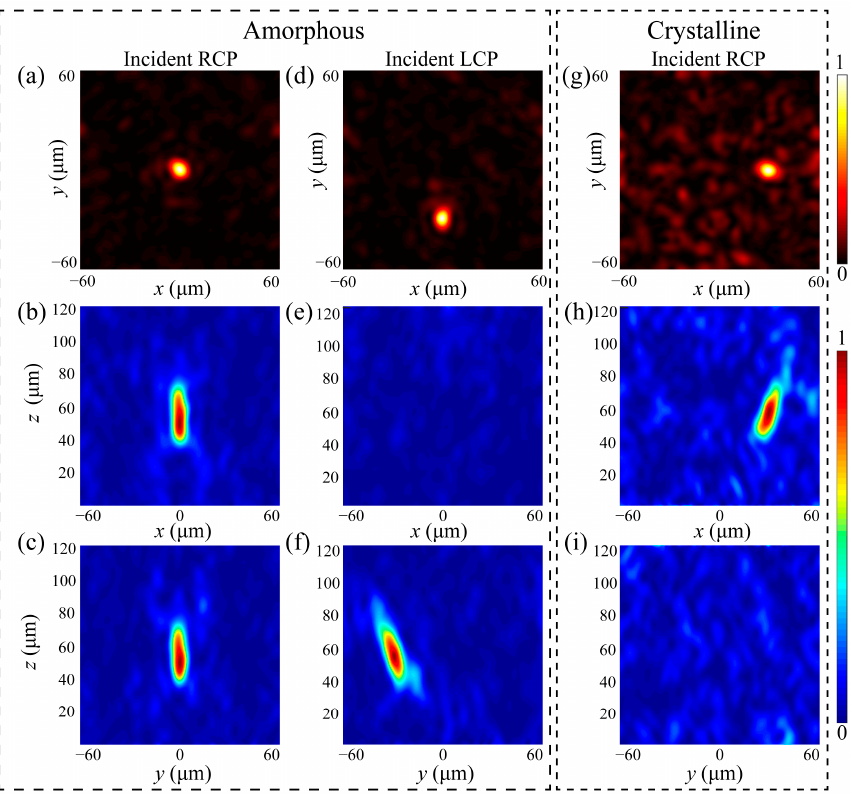
Figure 3. Simulated performance of the designed multi-focus metalens at different observation planes. ( a – c ) Electric field distributions when GSST is in A-state under RCP incidence. ( d – f ) Electric field distributions when GSST is in A-state under LCP incidence. ( g – i ) Electric field distributions when GSST is in C-state under RCP incidence. The upper row shows the E xoy results at z = 60 μ m. The middle row shows the E xoz results at y = 0. The bottom row shows the E yoz results at x = 0.